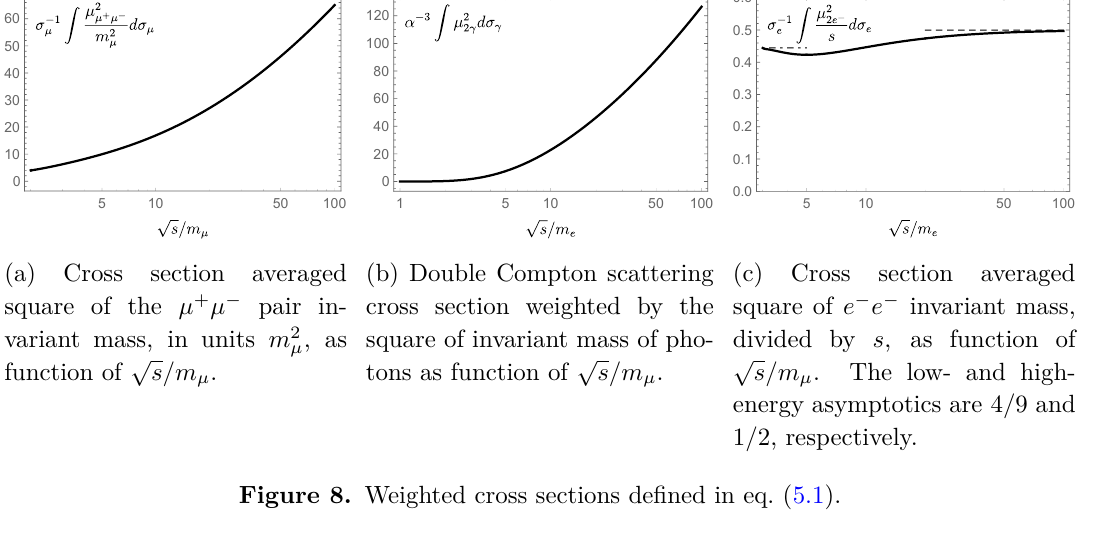
Figure 7. Exact cross section (solid curve) and asymptotics. The high-energy asymptotics (dotted line) corresponds to the leading term α 3 the next-to-leading term, would lead to the curve hardly discernible from the exact result: e.g., at √ s = 10 m e the difference is a tiny 0 . 4 %. Points show the numerical results of ref. [32].